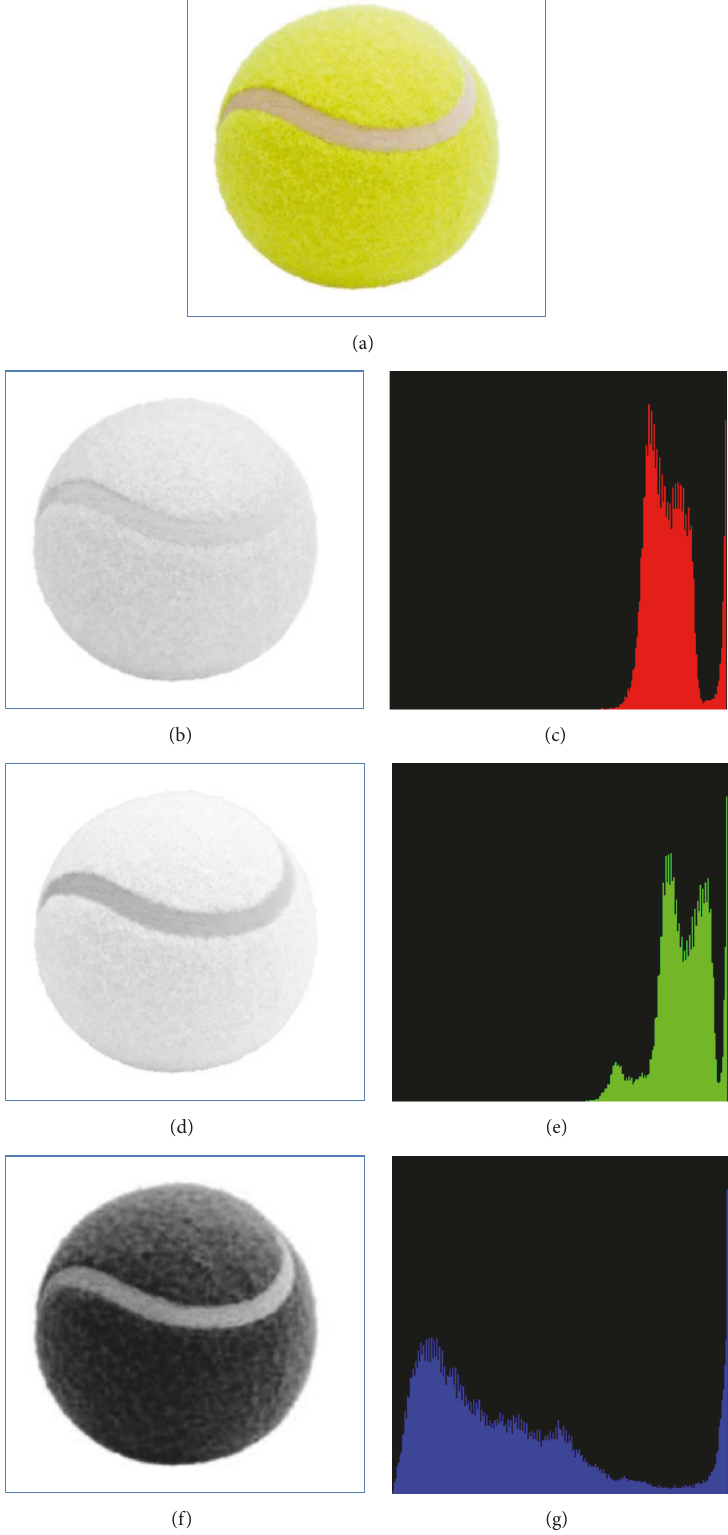
Figure 5: (a) Original photo, (b) ∼ (c) image and corresponding histogram of R component for target, (d) ∼ (e) image and corresponding histogram of G component for target, and (f) ∼ (g) image and corresponding histogram of B component for